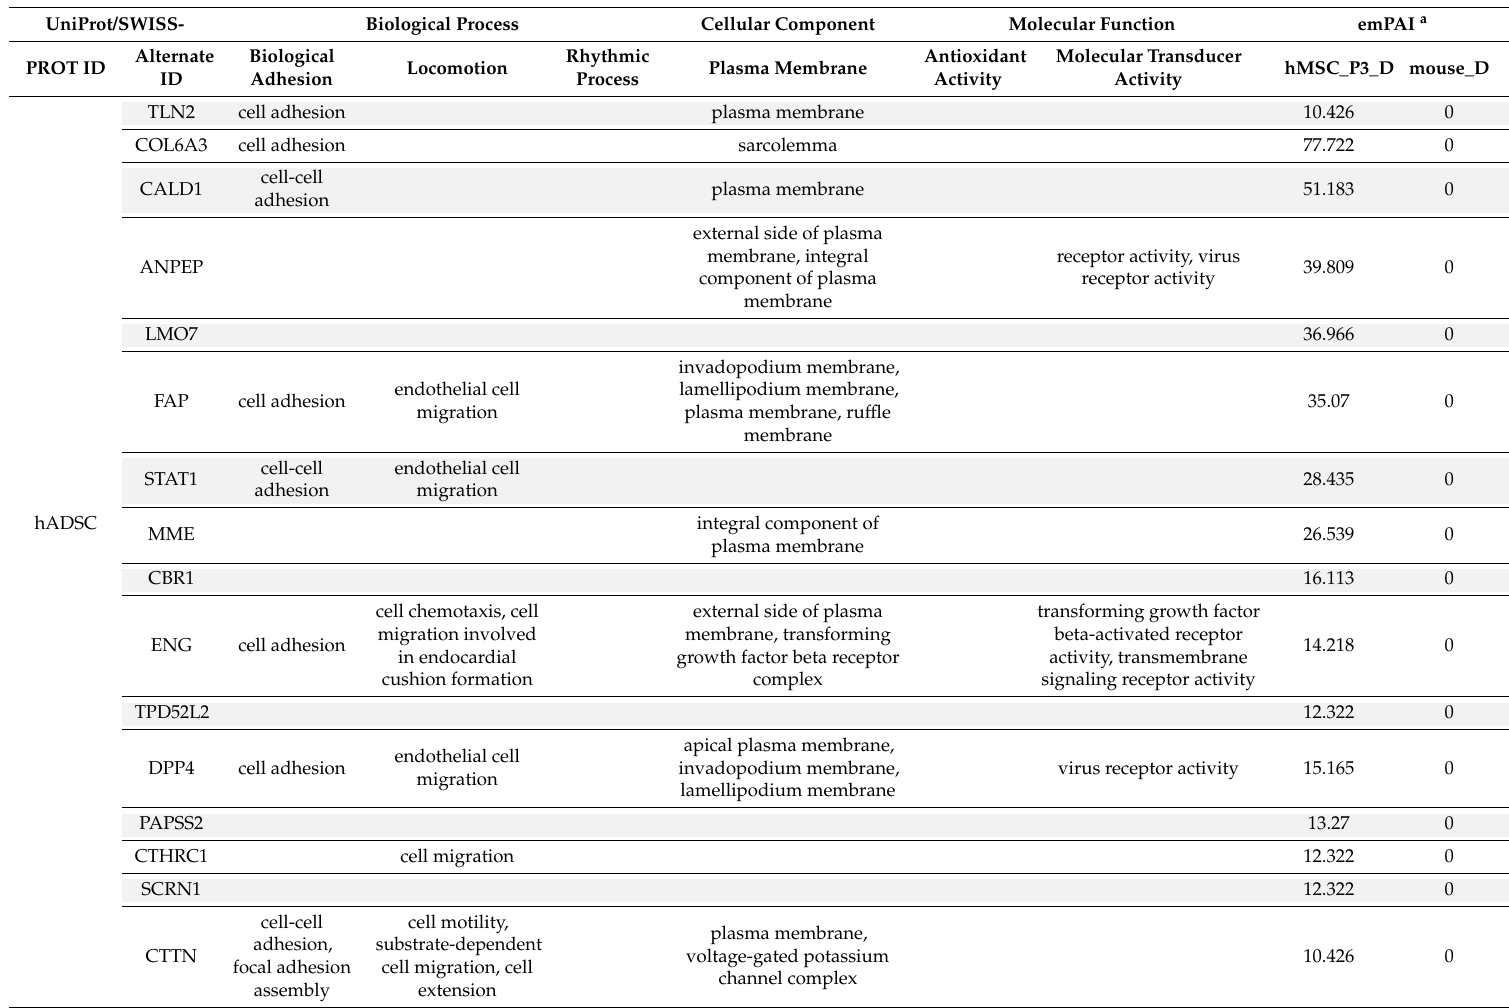
Table 1. Identification of endogenous proteins contained in hADSC;